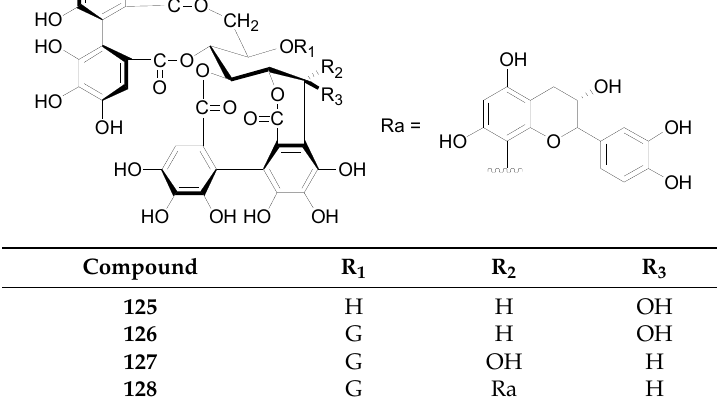
Table 7. Structures of compounds 125 – 128 .